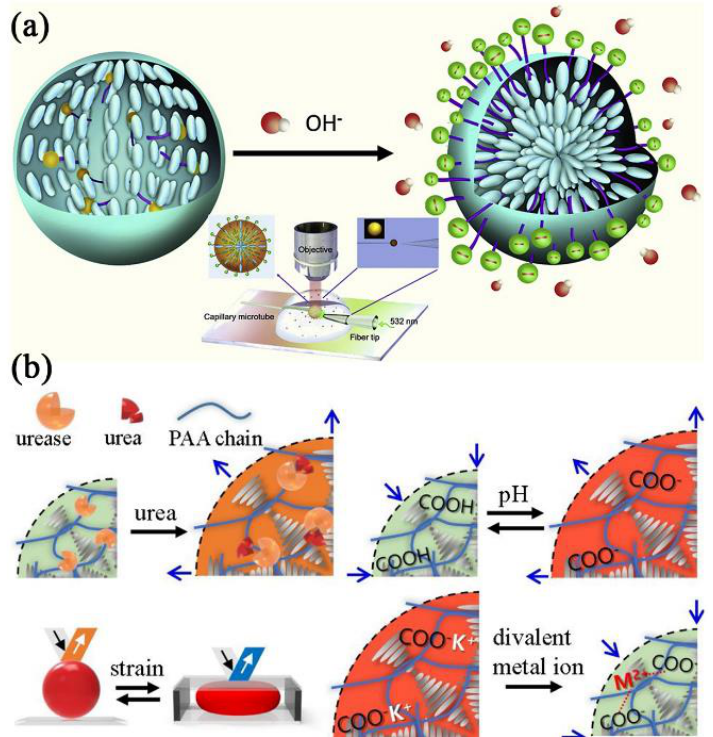
Figure 12. ( a ) Schematic illustration of the structural transition of stearic acid-doped 5CB microdroplet from planar anchoring to homeotropic anchoring. Reprinted with permission from ref. [41]. Copyright 2019 Elsevier. ( b ) Several tens of micrometer-sized photonic solid-state cholesteric LC (CLCsolid) balls have been functionalized with a weak anionic polyelectrolyte of poly(acrylic acid) in the form of an interpenetrating polymer network (IPN). Reprinted with permission from ref.